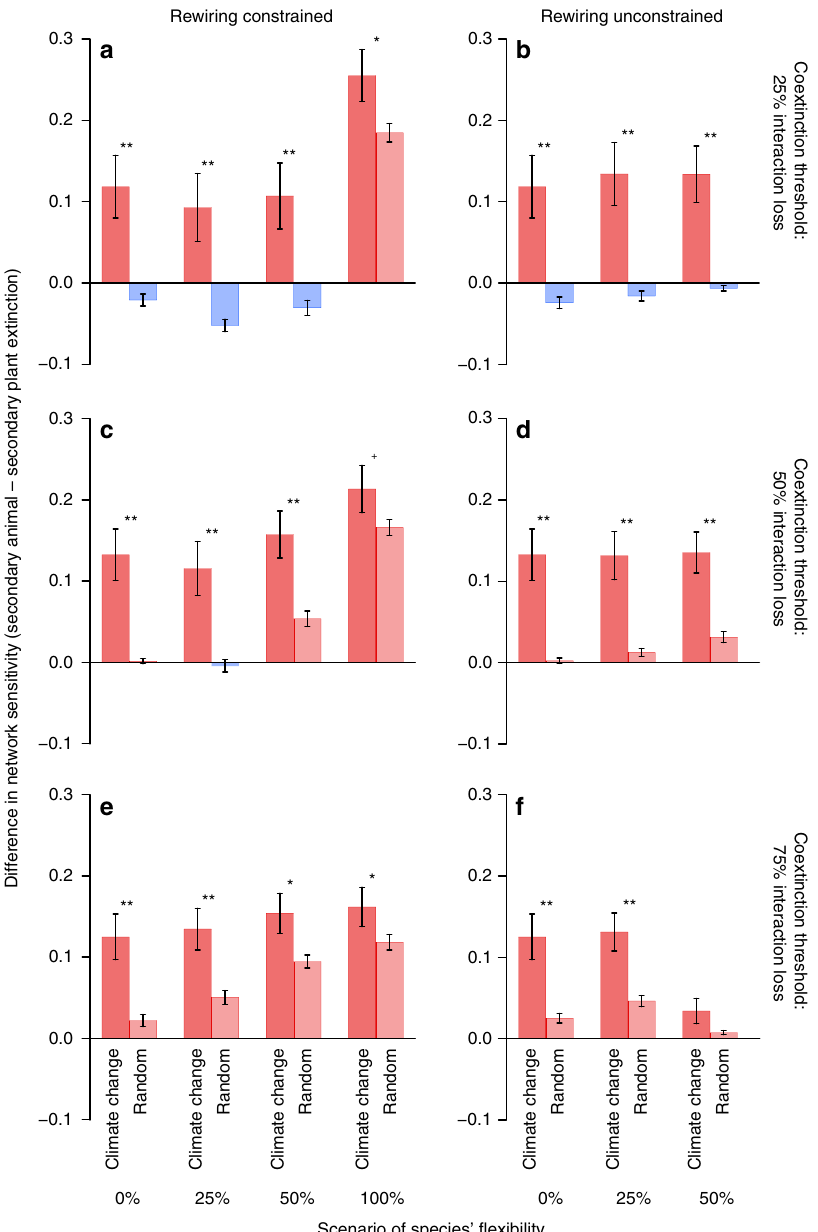
hange hange m ando ando c R R t e m a C li Figure 3 | Differences in sensitivity to species extinction across 13 mutualistic networks. Shown are differences in network sensitivity to plant versus animal extinction for different scenarios of species’ sensitivity to coextinction, rewiring capacity and flexibility. Coextinction thresholds varied between ( a , b ) 25%, ( c , d ) 50% and ( e , f ) 75% of interaction loss. Species were able to rewire interactions ( a , c , e ) to persisting partners (constrained rewiring) or ( b , d , f ) to all persisting species in each network (unconstrained rewiring). Flexibility values (0%, 25%, 50%, 100%) indicate the proportion of lost interactions that was reallocated to other species in the respective scenario; we omitted the very unlikely scenario of unconstrained rewiring and 100% flexibility as it requires all species to go extinct to trigger secondary extinction. Shown are mean differences ( ± 1 s.e.) across the 13 pollination and seed- dispersal networks between the impact of plant versus animal extinction; values 4 0 (red bars) indicate a higher risk of secondary animal than secondary plant extinction and values o 0 (blue bars) indicate the opposite. Secondary animal versus secondary plant extinction was compared between climate change and random extinction using two-sided, pair-wise t -tests ( þ P o 0.1; * P o 0.05; ** P o 0.01). Here climatic projections of the models of species’ vulnerability to climate change follow the RCP 8.5 scenario; results were identical for the RCP 6.0 scenario (see Supplementary Fig. 2). persisting species in the network (Fig. 3f). Empirical studies have bottom-up trophic cascades 13,26,27 . We found a high risk of shown a high variability of mutualistic plant–animal interactions animal coextinction, especially in simulations where animals were across years 30,31 , suggesting a high flexibility in these networks. In rather inflexible in choosing their plant partners. Apparently, the contrast, recent studies have highlighted the importance of higher sensitivity of mutualistic networks to plant than to animal partner fidelity in both antagonistic and mutualistic ecological extinction disappeared only in simulations where species could networks 32,33 that might be associated with a high degree of trait freely reallocate at least 50% of their lost interactions to all NATURE COMMUNICATIONS|7:13965|DOI: